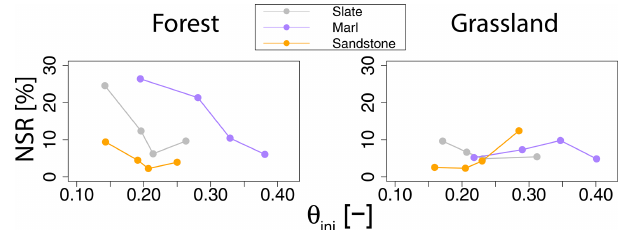
Figure 6. Relationship of NSR with θ ini for each landscape unit. Every point represents % NSR for all events which fall in the four different quartiles of initial soil moisture (the plotting position of θ ini value represents a quartile median). Number of events observed in the different classes can be found in the Supplement (Table